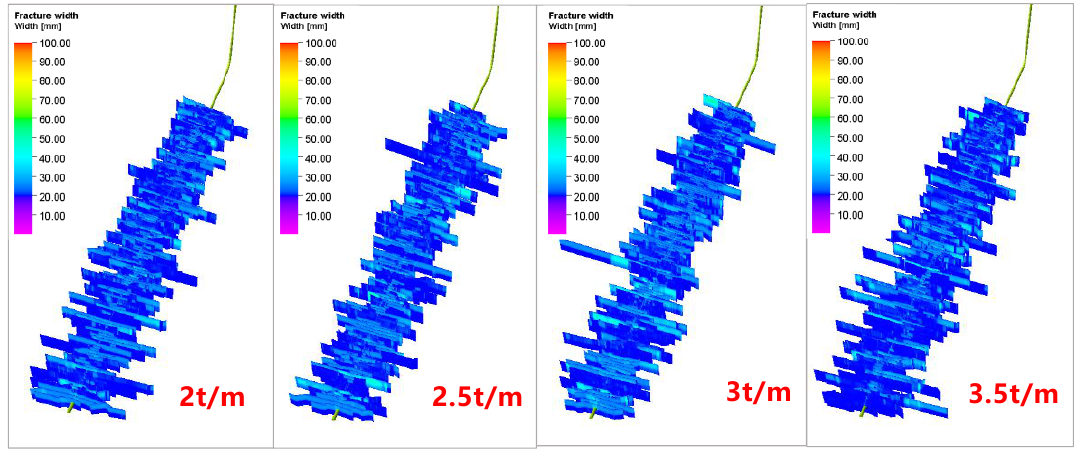
Figure 9. The change in fracture width under the different proppant mass.